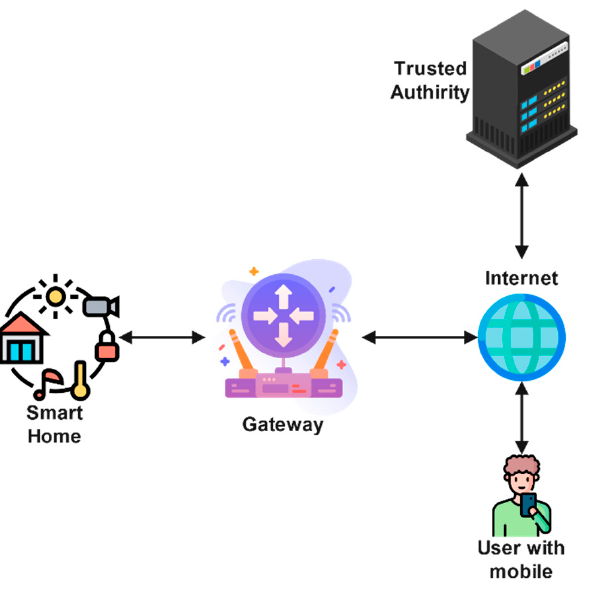
Figure 1. Smart home environment architecture diagram (adapted from